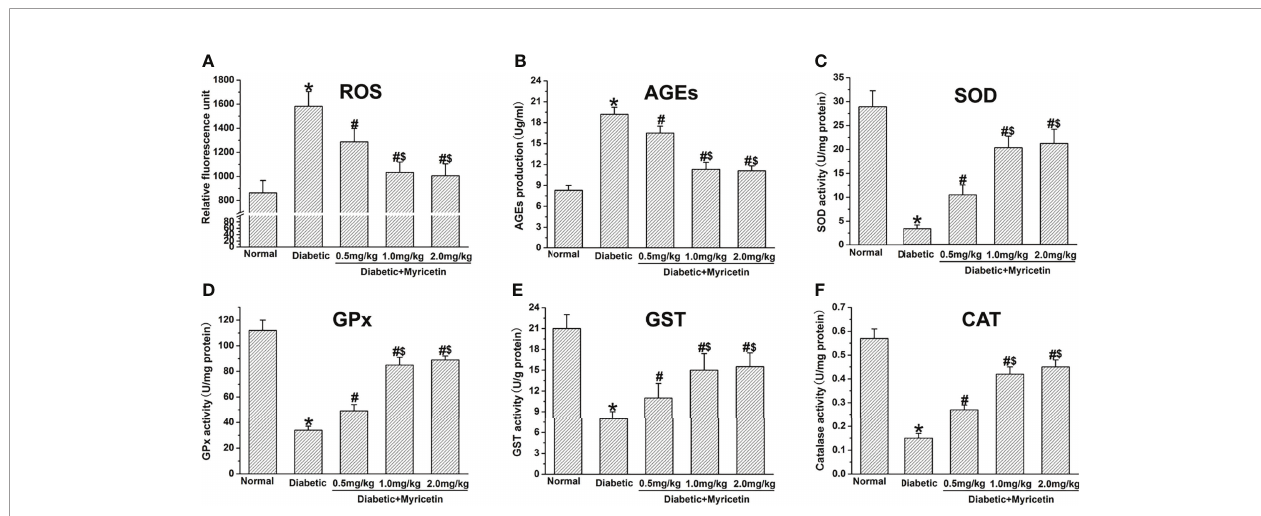
FIGURE 4 | The effect of myricetin on oxidative stress in diabetic rats ( n = 10 for each group). Myricetin signi fi cantly lowered the production of ROS (A) and AGEs (B) , and increased the activities of SOD (C) , GPx (D) , GST (E) , and CAT (F) in diabetic rats. * p < 0.05 for the comparison to the normal group, # p < 0.05 for the comparison to the saline-treated diabetic rats. $ p < 0.05 for the comparison to the diabetic rats treated with myricetin at 0.5